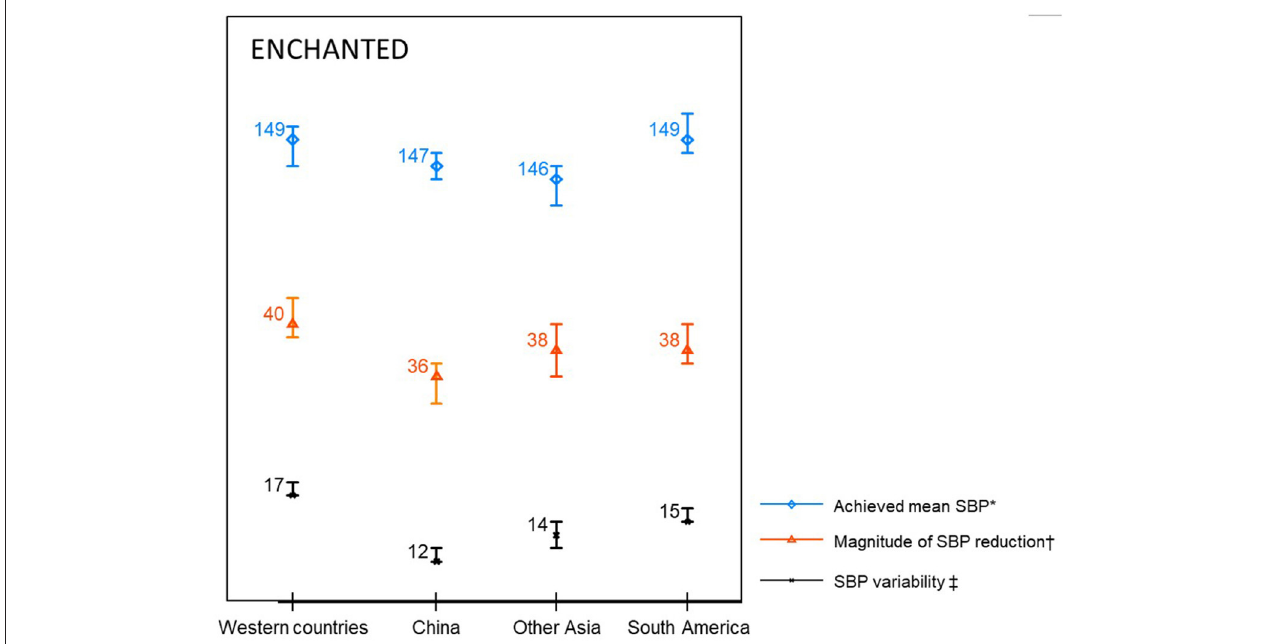
FIGURE 2 | Blood pressure parameters in the first 24h. SBP denotes systolic blood pressure. *Mean SBP in the first 24h. † SBP at randomisation minus minimum SBP within 24h. ‡Standard deviation of SBP in the first